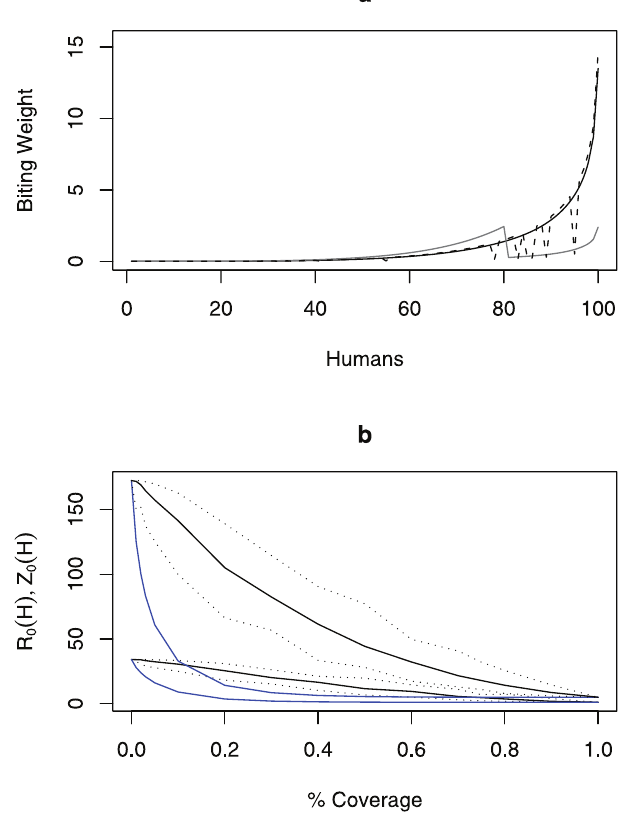
Figure 7. Changes in Transmission in Finite Populations with Heteroge- neous Biting under Control by ITNs or IRS (A) In a population with 20% coverage, total biting decreases, but some bites are redistributed, so biting increases on those who are unprotected. The baseline biting weights (solid black line) are plotted, along with the comparable post-control biting weights after targeted (solid grey) and random (dashed) ITN distribution or IRS application. (B) ITNs or IRS reduce transmission more efficiently when they are targeted. (Here, R 0 ¼ 40, R 0 ( H ) ’ 34, and Z 0 ( H ) ’ 172.) For example, 10% targeted coverage (blue lines) and 70% random coverage (black lines; the solid line is the median and the dotted lines show the fifth and 95th quantiles) reduce Z 0 ( H ) (the lines that originate at 172) by about the same amount at the median. For these parameters, 100% coverage is required to reduce R 0 ( H ) below one, so for higher R 0 values, 100% ITN or IRS coverage would be insufficient to eliminate malaria.